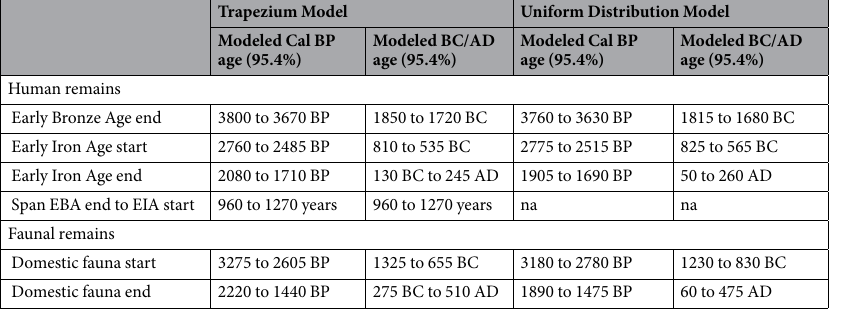
Table 1. Modeled radiocarbon ages for human remains and domestic faunal remains. Date ranges are given at 95% confidence